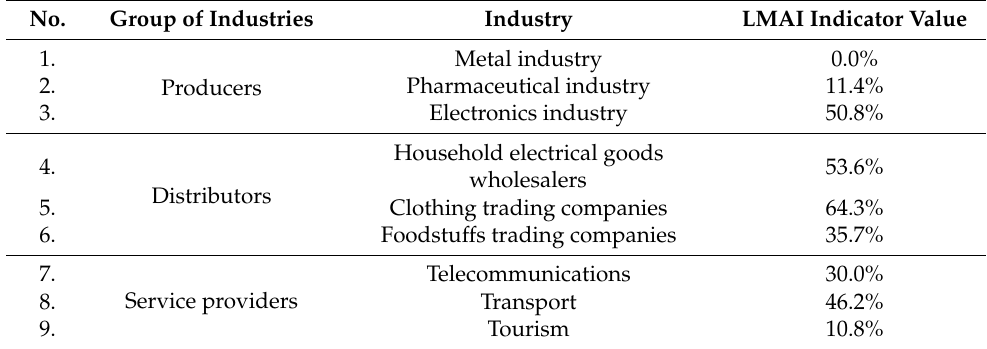
Table 8. LMAI values in Polish